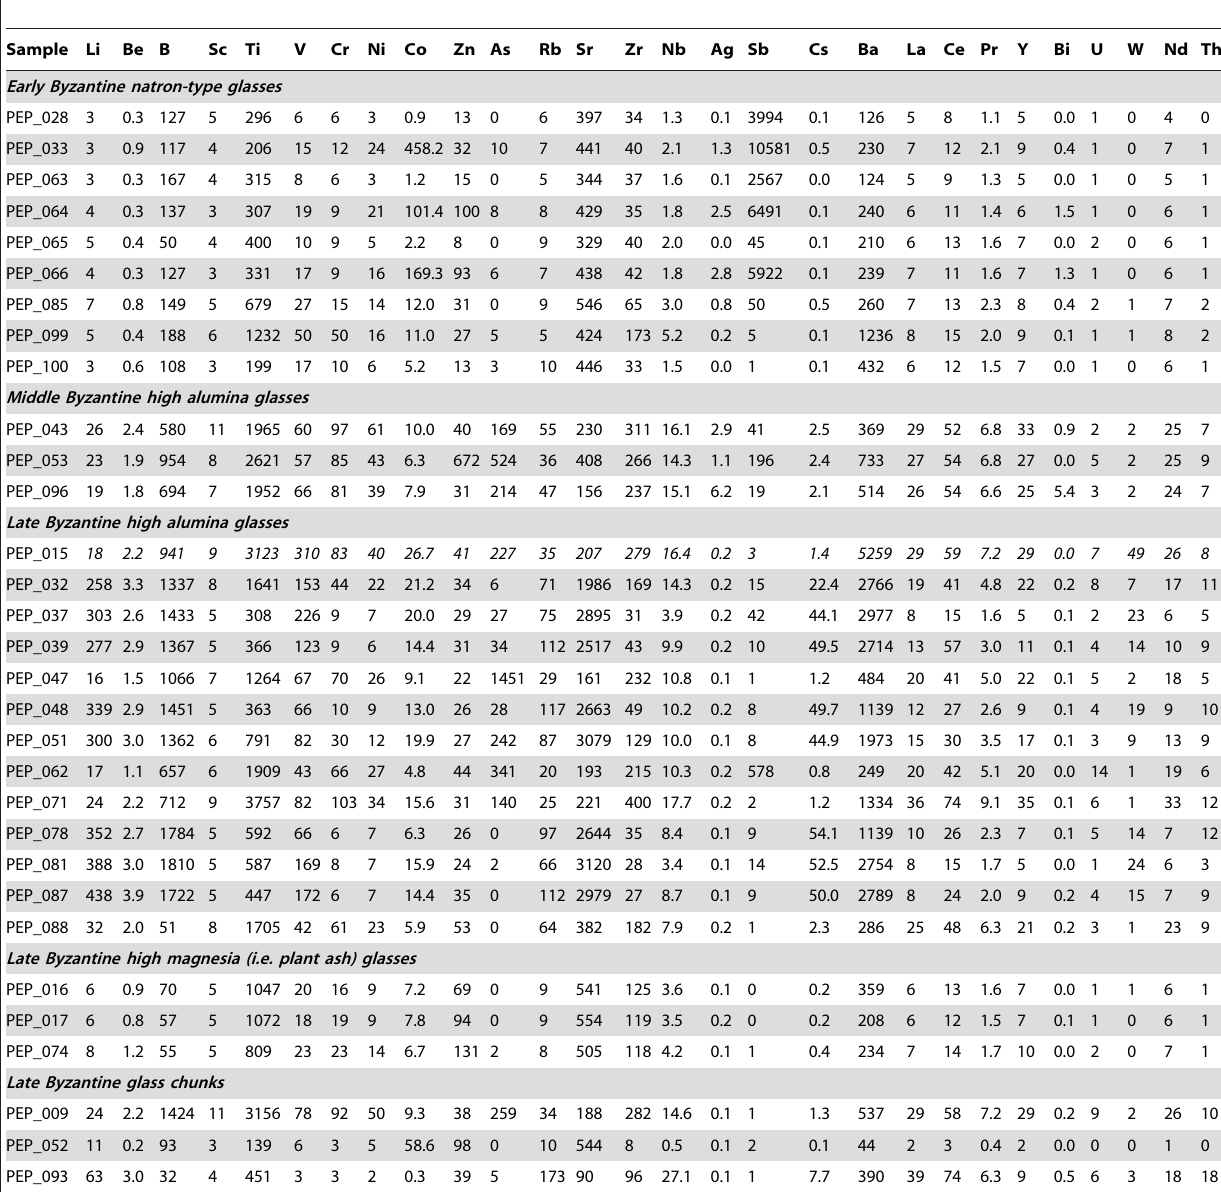
Table 2. Trace element results from the LA-ICP-MS analysis (n=4; values given in ppm) divided into chronological and chemical